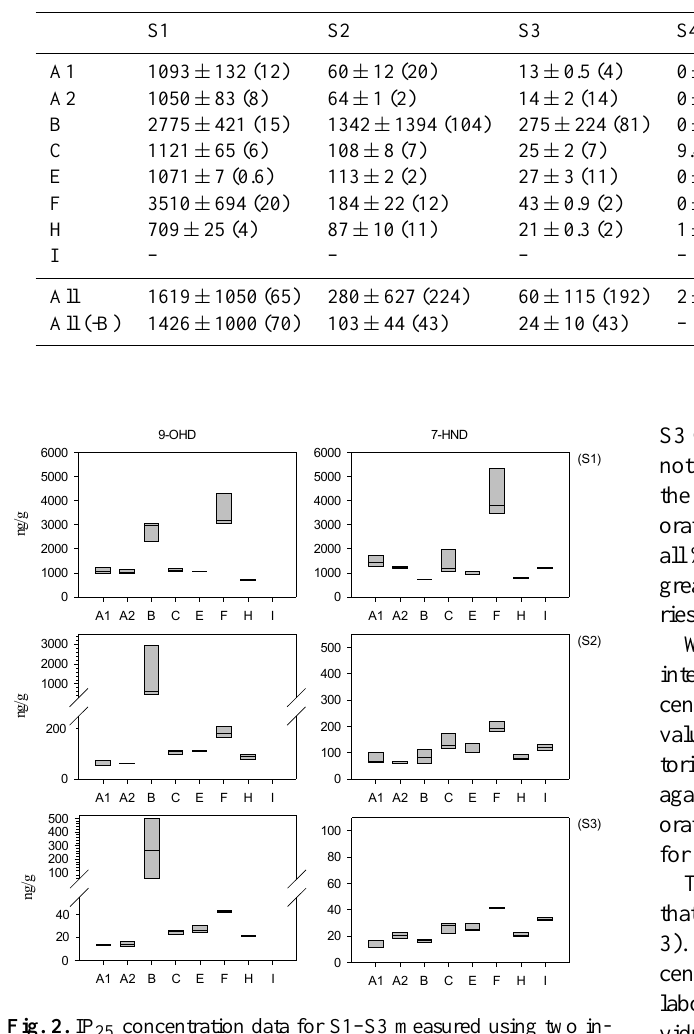
Fig. 2. IP 25 concentration data for S1–S3 measured using two in- ternal standards (9-OHD and 7-HND). In each case, the horizontal lines within each box correspond to the individual measurements within